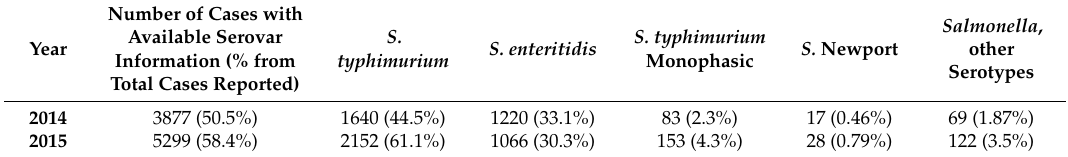
Table 6. Salmonella spp. related notifications reported by